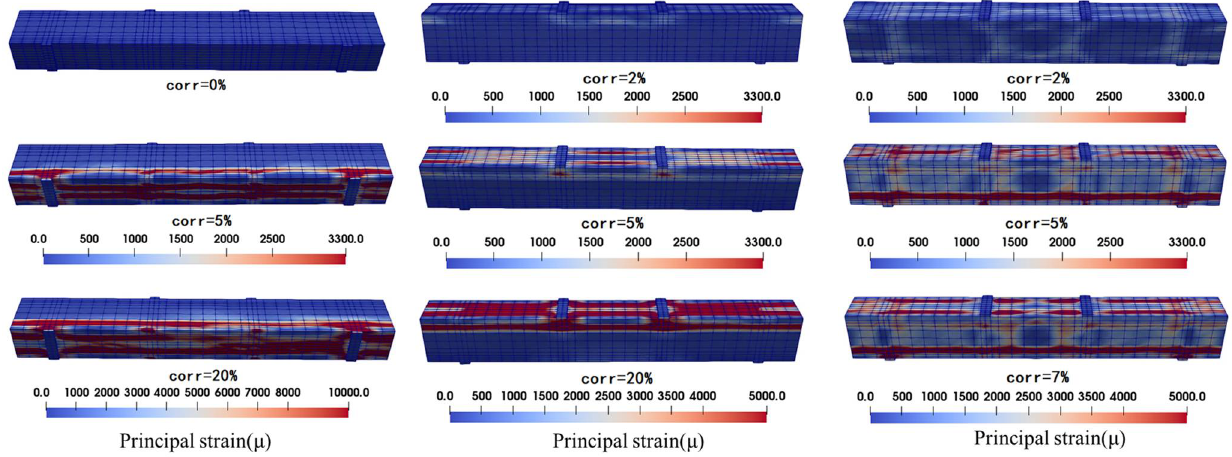
Figure 8. Principal strain clouds of RC beams at the end of rusting at different rusting